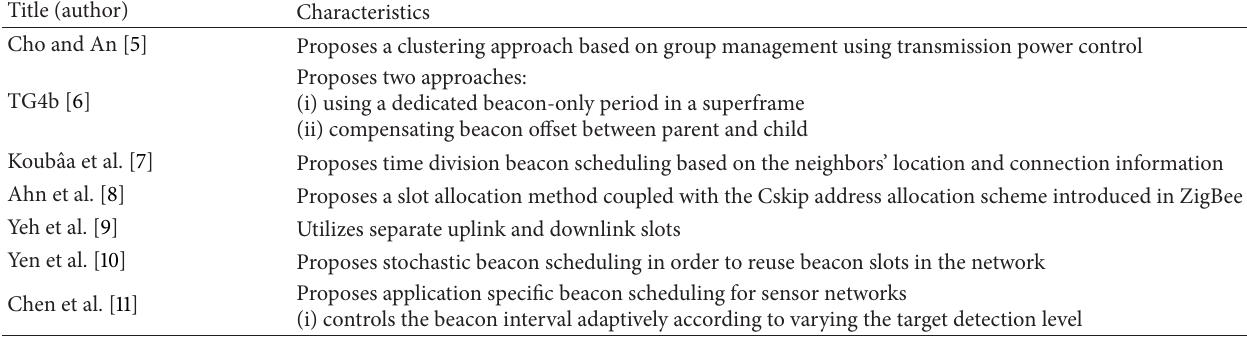
Table 1: Tree-based beacon scheduling.